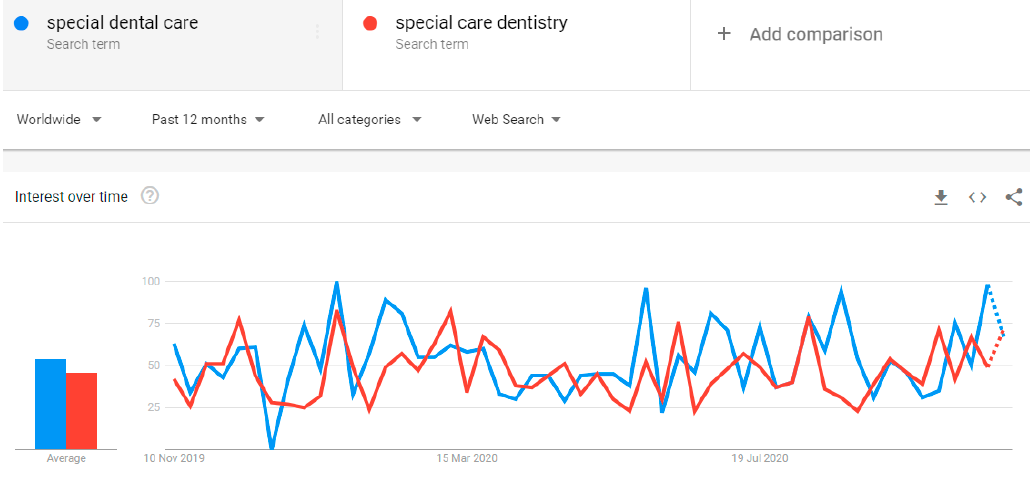
Figure 2. The worldwide online searching for ‘special dental care’ and ‘special care dentistry’ terms (data extracted from Google Trends, accessed 14/11/2020) over the last 12 months.